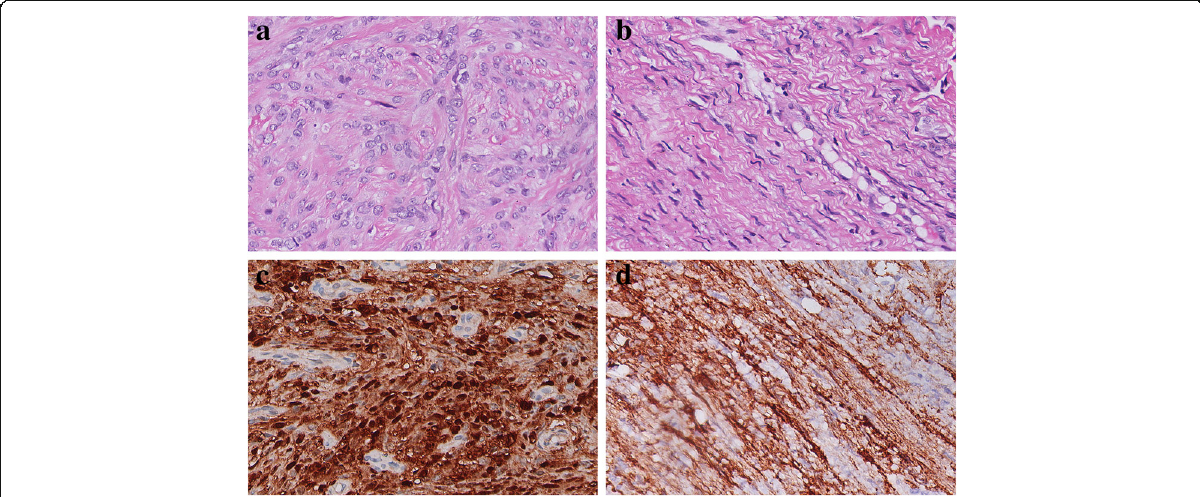
Fig. 2 Histological and immunohistochemical characteristics of the hypocellular areas. a . Epithelioid cells with bland nuclei and eosinophilic cytoplasm arranged in small clusters within fibromyxoid matrix. Haematoxylin-eosin staining, 400x magnification. b . Elongated spindle cells arranging in a lamellar architecture harboured wavy, thin nuclei and delicate bipolar cytoplasmic processes. Haematoxylin-eosin staining, 400x